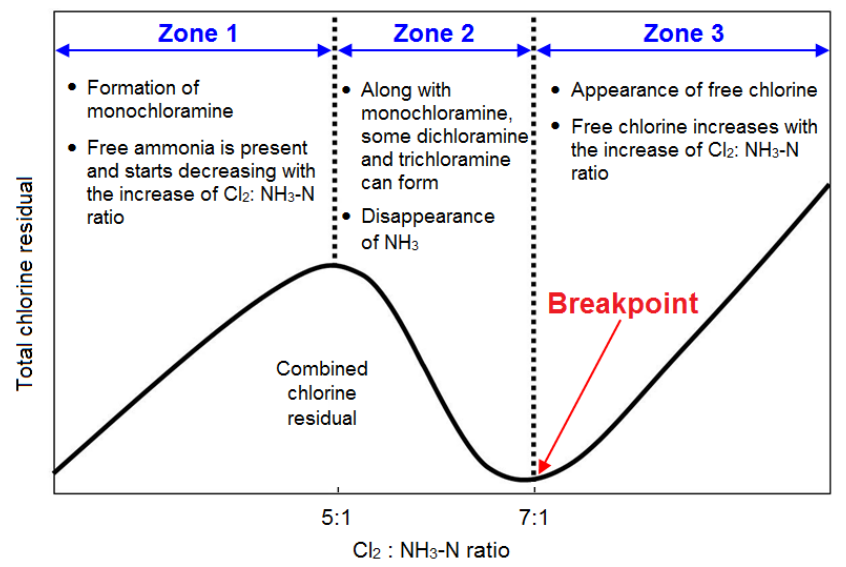
Figure 5. Typical breakpoint curve. Formation of monochloramine dominates in zone 1 with some free ammonia is present; zone 2 is associated with the disappearance of free ammonia and an increased amount of dichloramine and trichloramine formation; free chlorine largely appeared in zone 3.